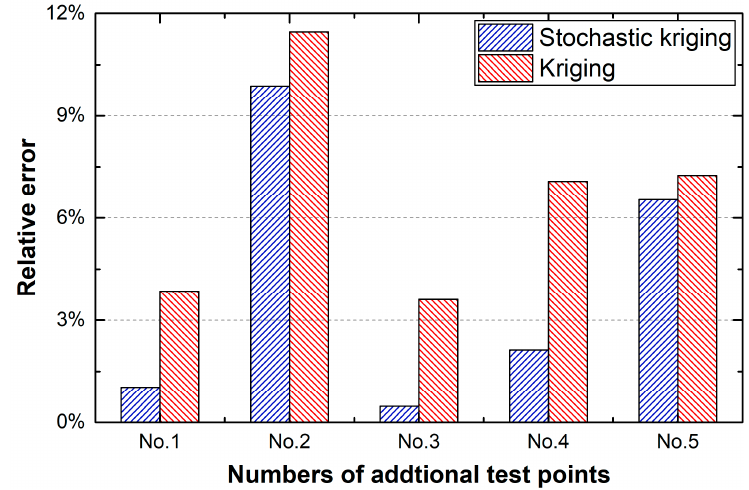
Figure 8. Relative prediction errors of the stochastic kriging model and the kriging model.